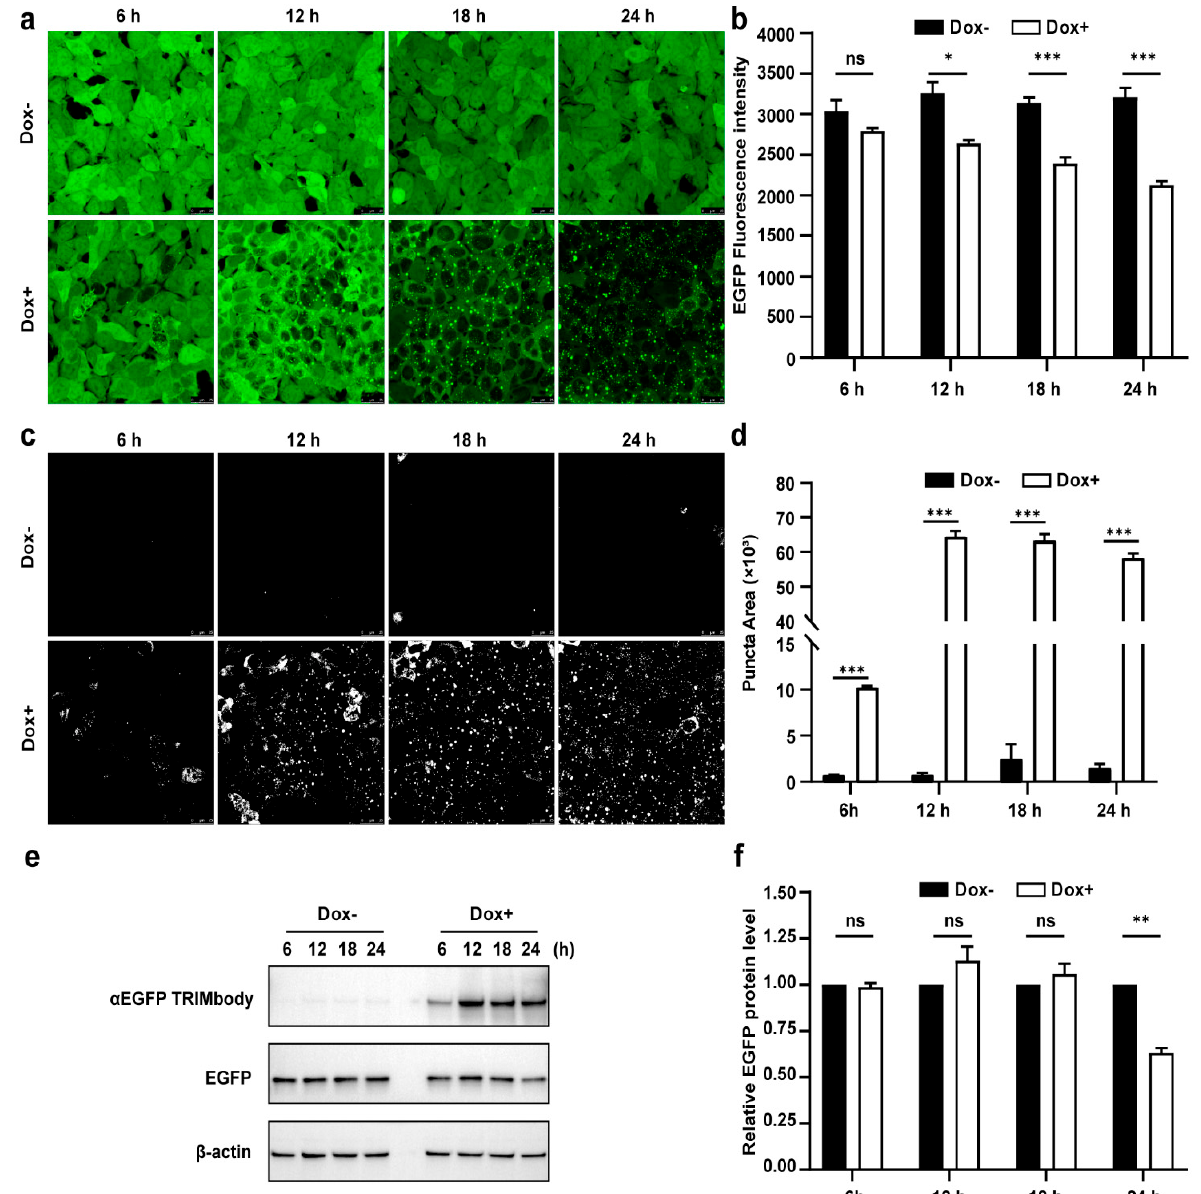
Figure 3. Characterization of α EGFP TRIMbody temporal expression pattern. ( a ) Laser scanning confocal fluorescence microscopy images showed the change in EGFP expression over time with and without Doxycycline. Scale bars are 25 µm. ( b ) Mean fluorescence intensity of EGFP in cells that were untreated or treated with Dox. Mean fluorescence intensity is measured using flow cytometry and indicated by bar graphs ( n = 3 replicates per group). Data represent the mean ± SEM. The ns represents no significance, * represents p < 0.05, and *** represents p < 0.001. ( c ) EGFP fluorescent puncta was examined from fluorescent images using ImageJ software. ( d ) Relative EGFP puncta area of autophagosomes or autolysosomes was measured using ImageJ software. Statistical analysis of the puncta area of autophagosomes and autolysosomes per cell were samples from a pool of at least 3 images. Data represent the mean ± SEM. ns represents no significance, *** represents p < 0.001. ( e ) Western blotting analyzed EGFP and α EGFP TRIMbody levels in the total cell lysate at the indicated times. Equal amounts of cell lysates (10 µg) were loaded in each well and immunoblotted with anti-Flag antibody. ( f ) Graphs show statistic results from relative optical density of bands on the blots. Values are the mean ± SEM. ( n = 3/group). Statistical significance between ligands was determined using a two-way ANOVA test. ** p < 0.01, versus control.